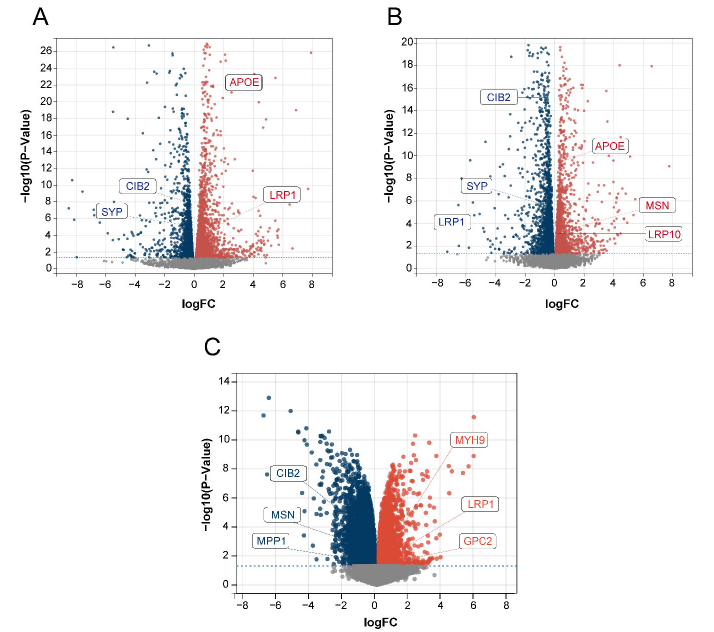
Figure 9. Volcano plot of DEGs. The red color represents up ‐ regulated genes, and the blue color represents down ‐ regulated genes. ( A ) Data 1 DEGs volcano plot. ( B ) Data 2 DEGs volcano plot. ( C ) GSE156646 DEGs volcano plot.